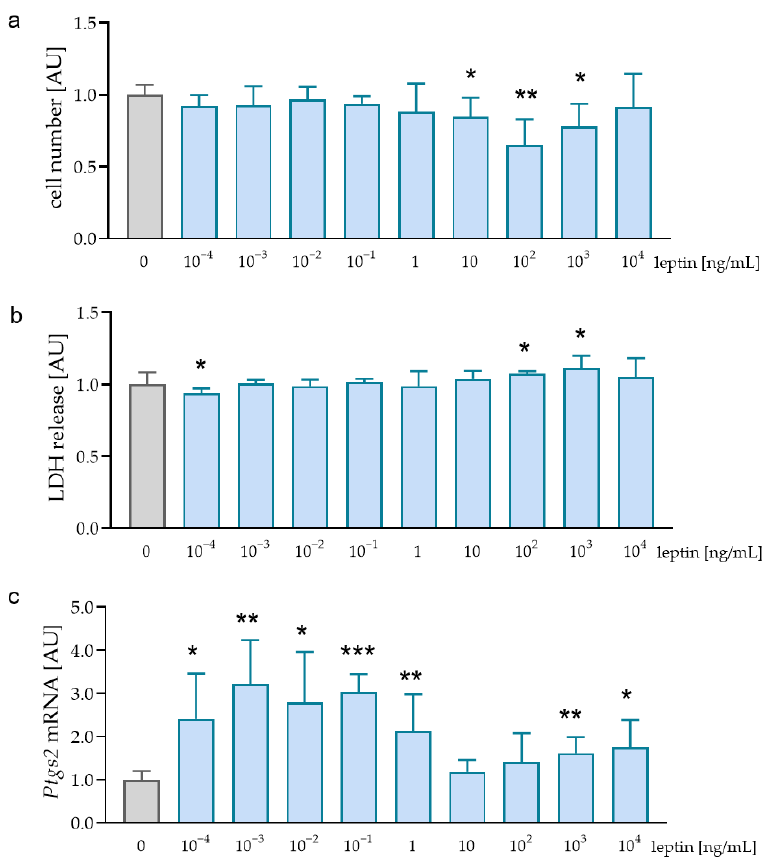
Figure 1. Cell number ( a ), lactate dehydrogenase (LDH) release ( b ), and Ptgs2 gene expression ( c ) after treatment of RAW264.7 macrophages with different leptin concentrations. n ≥ 5; Statistics: ANOVA followed by unpaired t-tests with Welch-correction. * p < 0.05; ** p < 0.01; *** p < 0.001 compared to 0 ng/mL leptin.